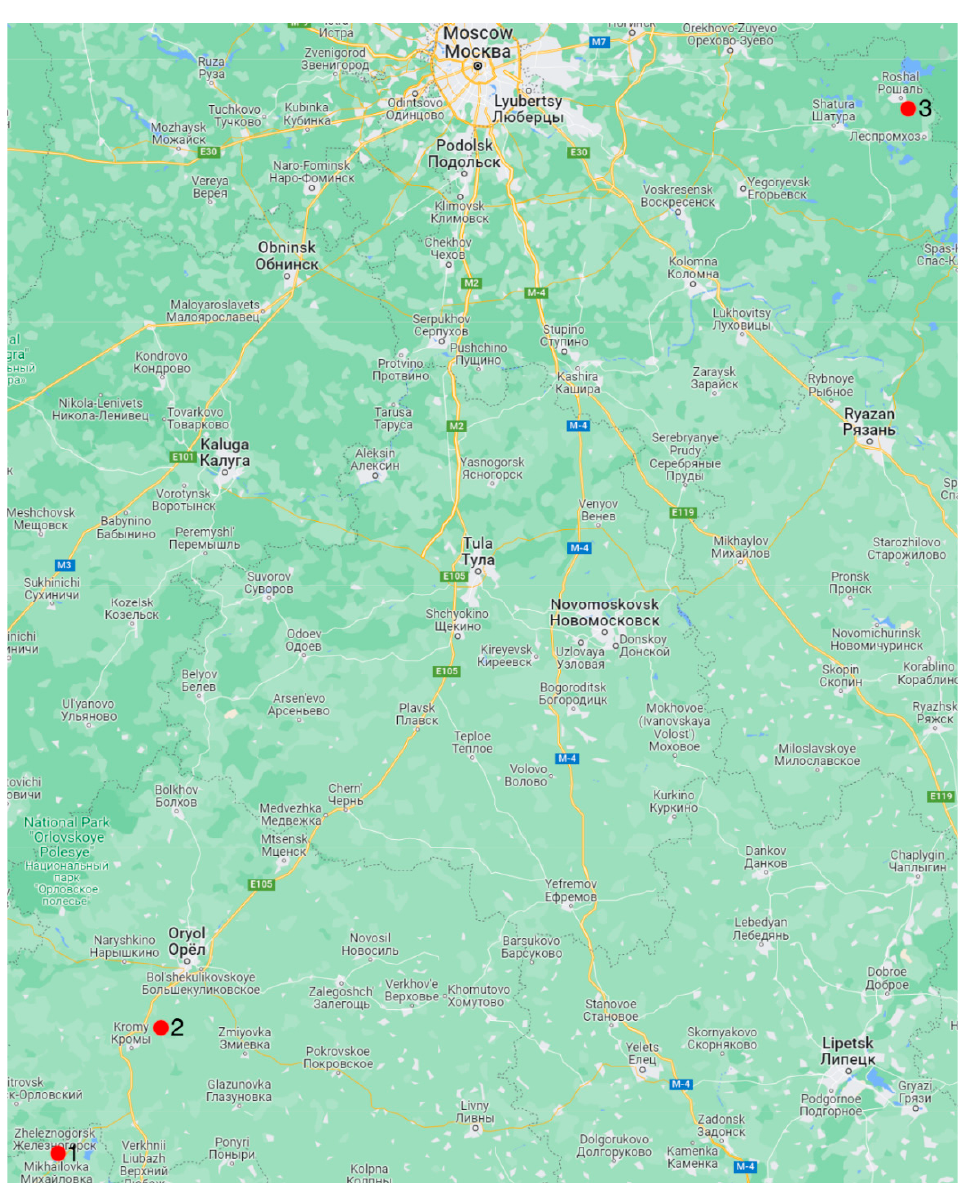
Figure 1. Collection locations of Gryphaea dilatata Sowerby, 1816: 1—Kursk region, near the town of Zheleznogorsk, Mikhailovsky quarry; 2—Oryol region, Kromy district, sand quarry near the village of Sukhochevo; 3—Moscow region, Shatura district, sand quarry on the outskirts of the town of